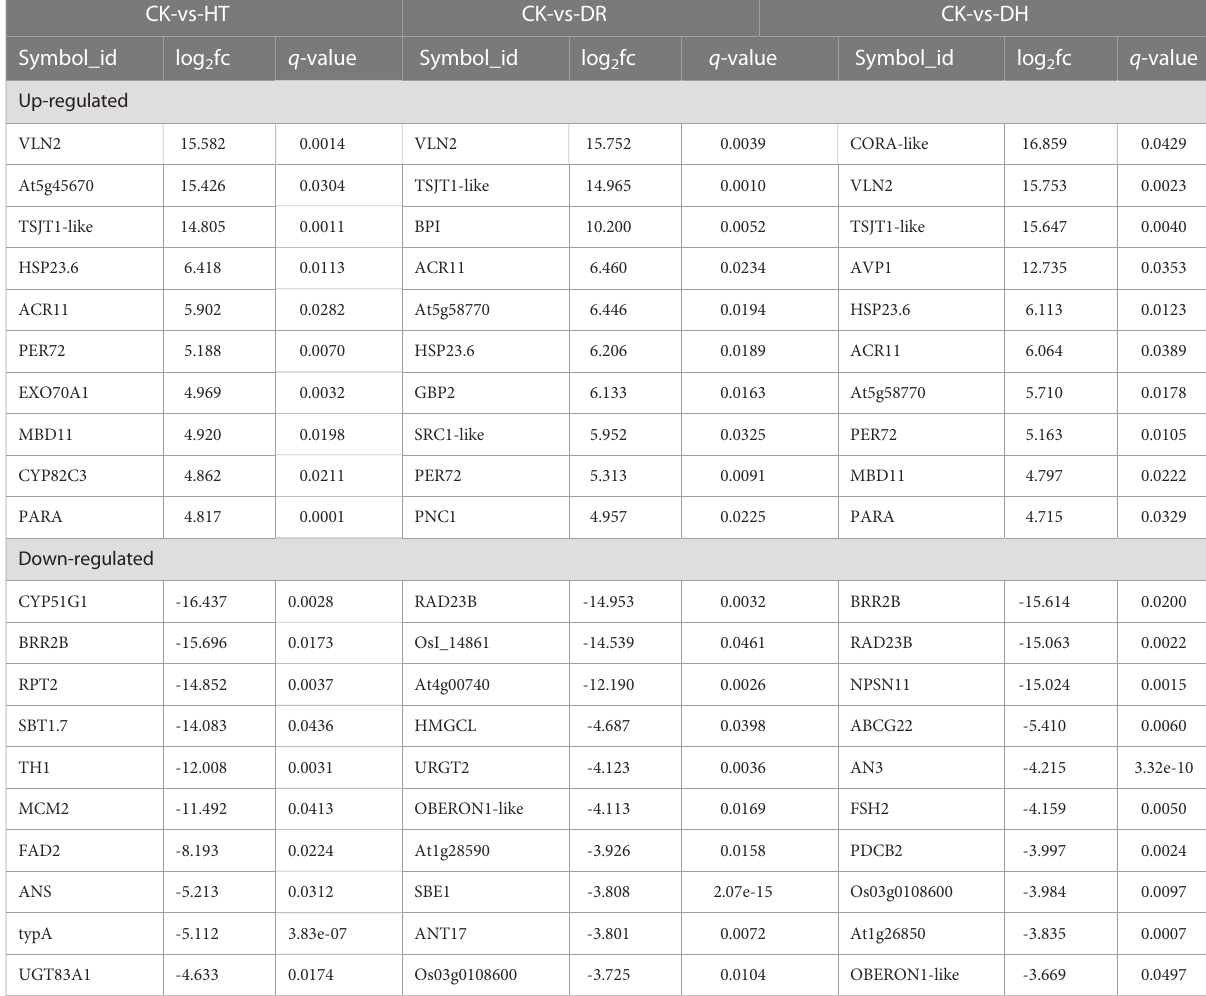
TABLE 2 Top 10 up- and down-regulated proteins in HT, DR, and DH identi fi ed by DIA. CK-vs-HT CK-vs-DR